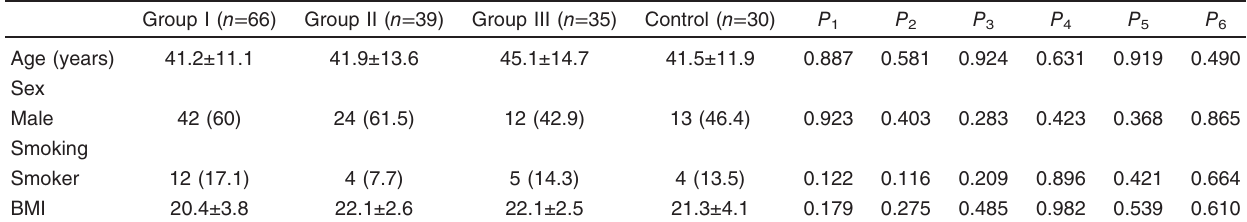
Table 1 Demographic data of the study